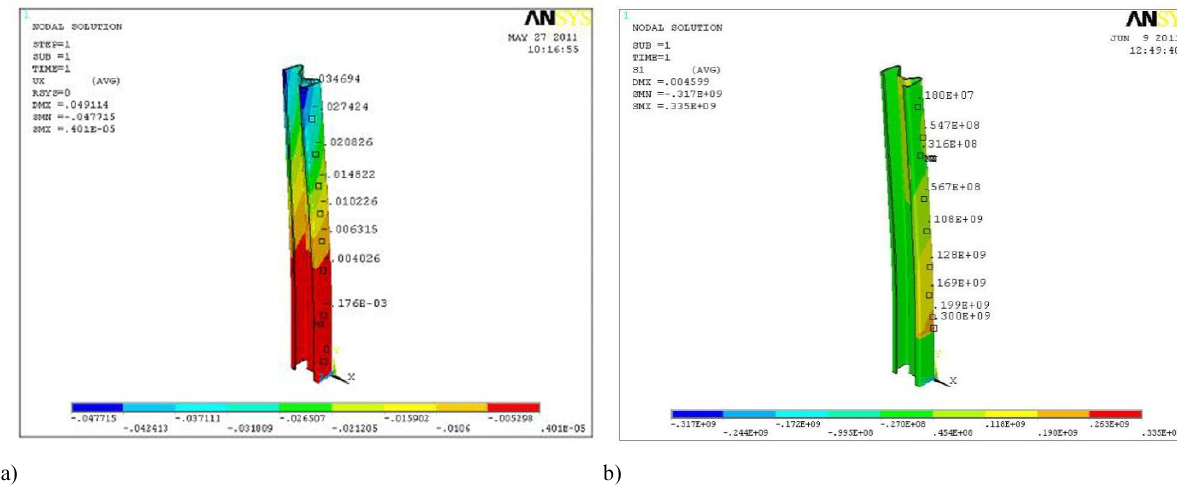
Fig. 11. The post MST-2 mounted on a bridge or a viaduct: a – deflections, b – stresses (our research)